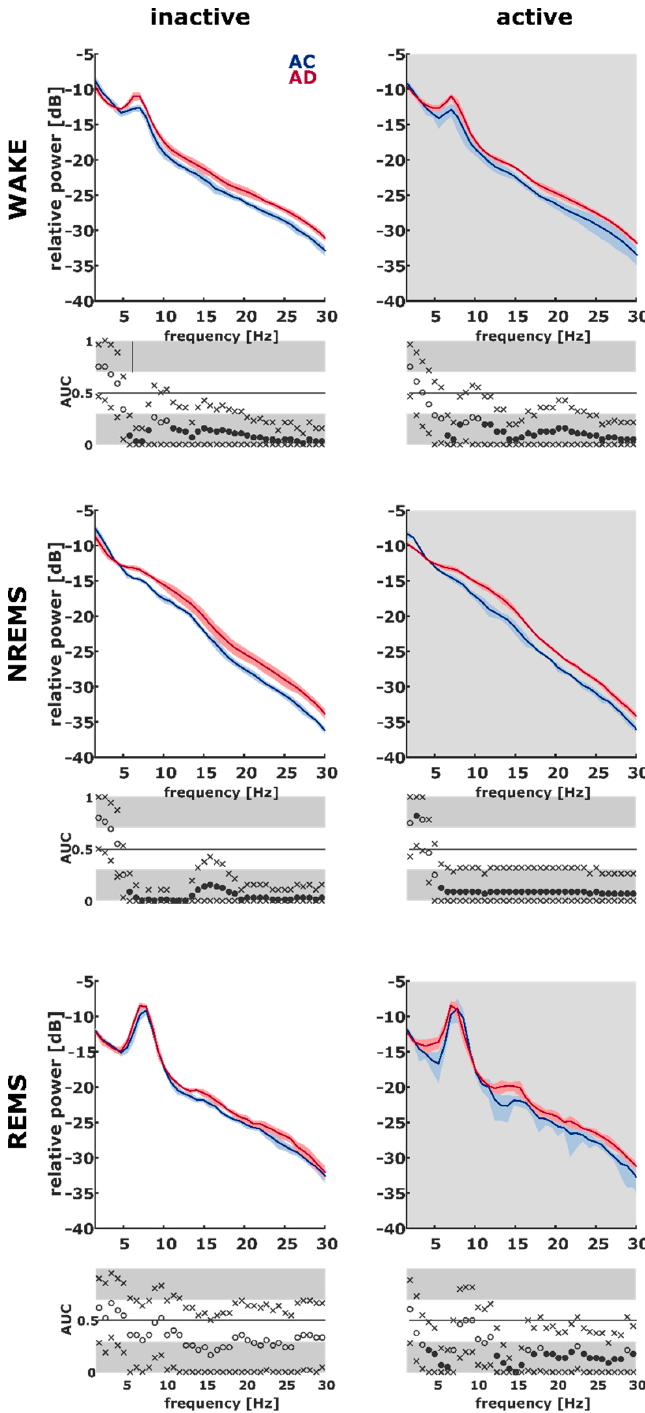
Figure 5. Plots of the median of the relative spectral power for the control group (AC, n = 7, for REM: n = 5, blue) and the Alzheimer’s (AD, n = 8, for REM: n = 6, red) group as recorded from the rostral electrode. The light blue and red shaded areas indicate the median absolute deviation. The accompanying AUC plots including the 95% confidence intervals represent the results of the statistical analysis. Dots indicate the calculated AUC, x signs indicate the limits of the 95% confidence intervals. A filled dot indicates a significant difference as determined by the 95% confidence interval exclusive 0.5. The areas in gray indicate an AUC > 0.7, i.e., an AUC value corresponding to an at least acceptable effect. REMS: REM sleep; NREMS: NREM sleep